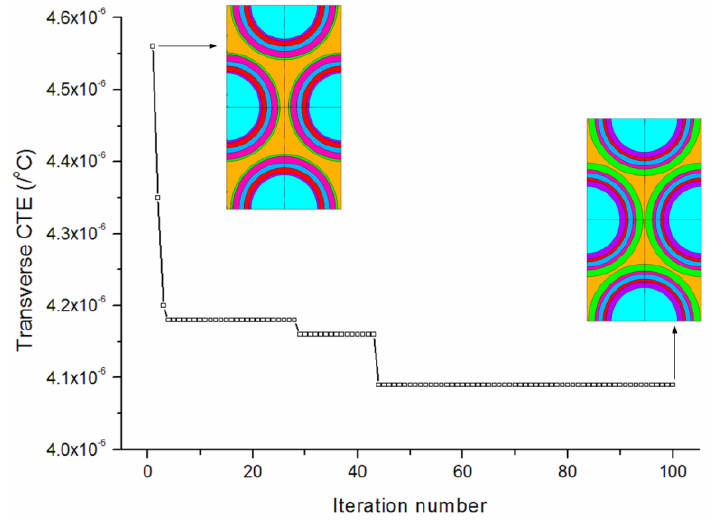
Figure 8. Convergence rates of the optimization procedure for minimizing the transverse CTE.